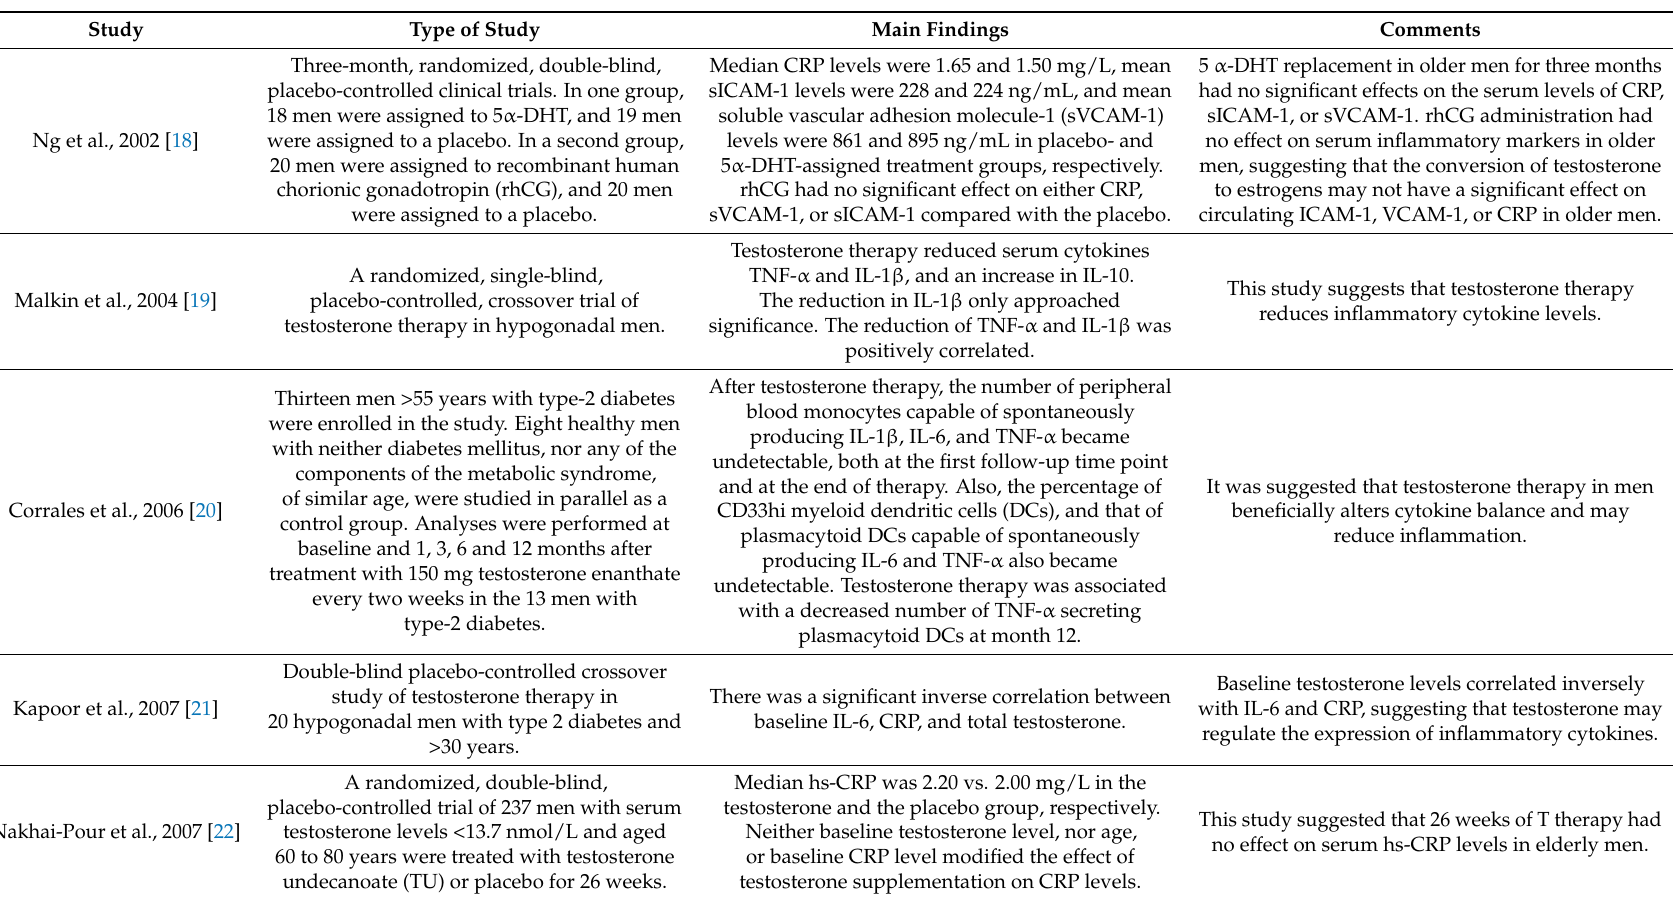
Table 2. Effects of testosterone therapy on inflammatory